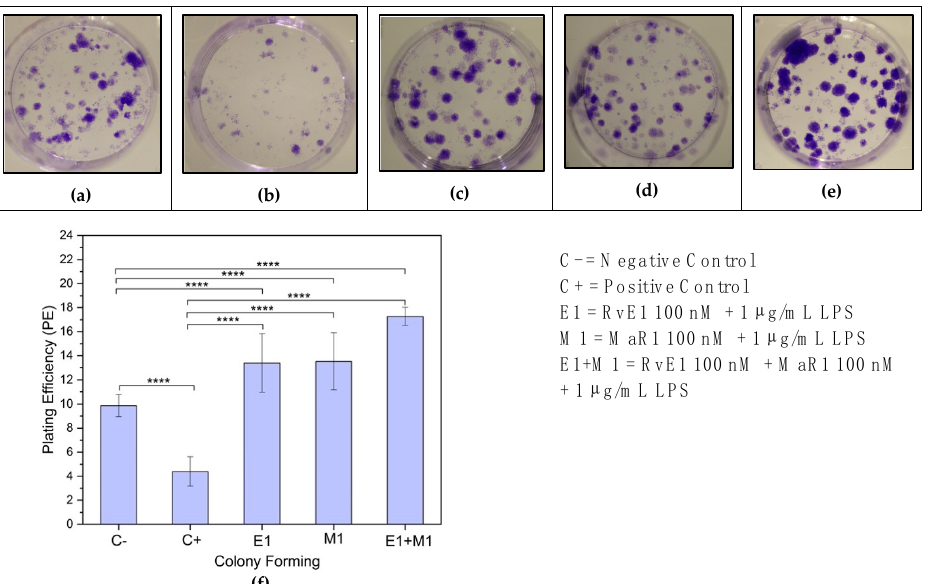
Figure 4. Clonogenic assay and plating efficiency at day 14 shows the mean values of CFUs among the five study groups, ( a ) Negative controls, ( b ) Positive controls, ( c ) RvE1 00 nM + 1 µ g/mL LPS, ( d ) MaR1 100 nM + 1 µ g/mL LPS and ( e ) RvE1 100 nM + MaR1 100 nM + 1 µ g/mL LPS. Colony- forming unit (CFU) experiment was conducted three times ( n = 3) for all experimental groups on three different plates simultaneously and average values calculated. Shown above is a representation of one of the stained plates ( a – e ) and quantitative histograms of averaged intensity representations. ( f ) CFU mean values of groups (3, 4, and 5) were significantly higher than controls as indicated in the figure. (**** p ≤ 0.0001). Assessment of TGF- β 1, IL-10, and IL-4 shows high statistical significant differences among the five study groups based on the normalized mean TGF- β 1 (F = 268.772, p ≤ 0.0001), IL-4 (F = 85.446, p ≤ 0.0001), and IL-10 (F = 462.232, p ≤ 0.0001). The expression of TGF- β 1 and IL-10 was significantly higher in Group-5 (RvE1 100 nM + MaR1 100 nM + 1 μ g/mL LPS) when compared to the other four groups (Figure 5).